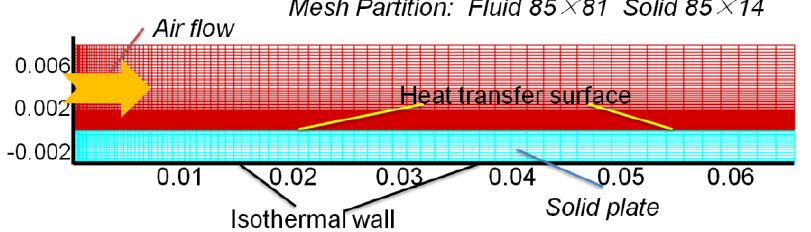
Figure 1. Computational domain and mesh for heat convection along a flat